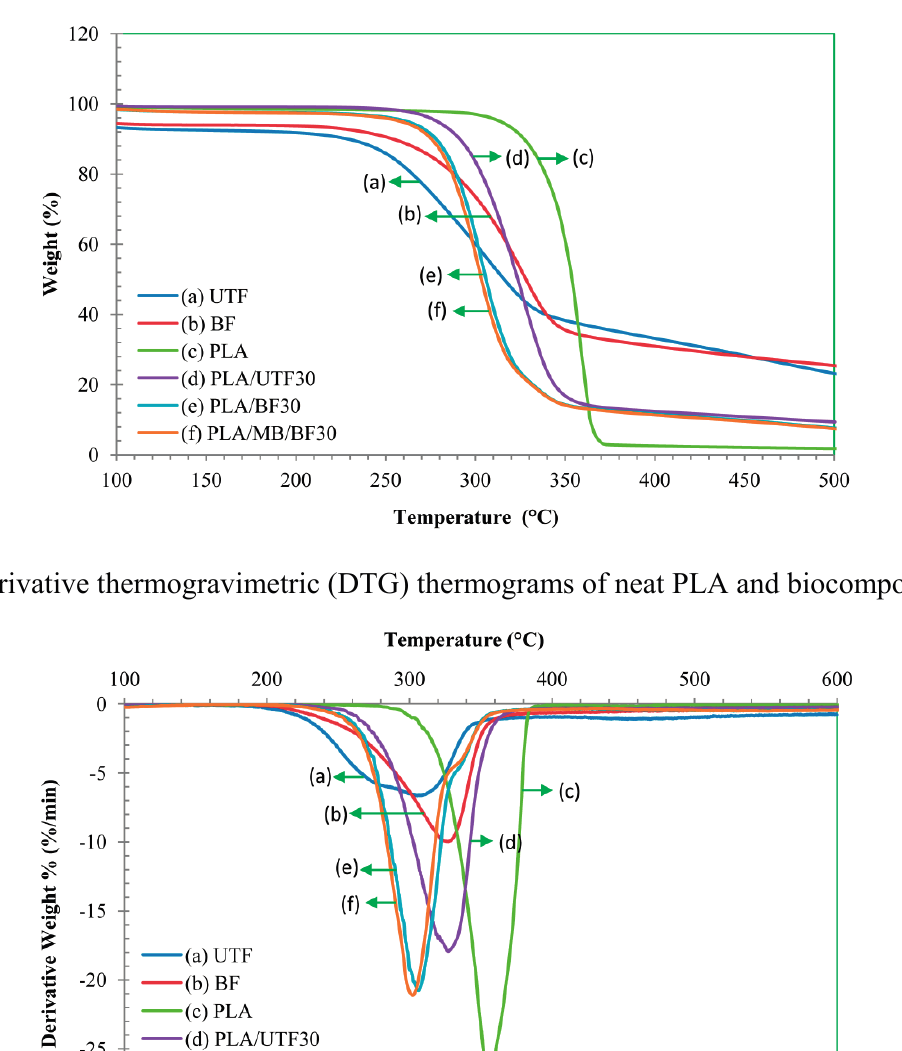
Figure 11. Thermogravimetric analysis (TGA) thermograms of neat PLA and biocomposites (70:30).